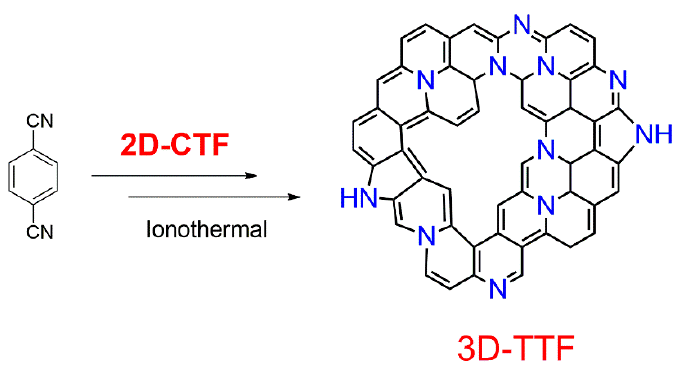
Figure 6. Bottom-up strategy to prepare 3D TTF (thermalized triazine-based framework) catalysts for oxygen reduction reaction by trimerization of terephthalonitrile at high temperatures (adapted from [82]). Reprinted with permission from [82]. Copyright 2015, Wiley-VCH.